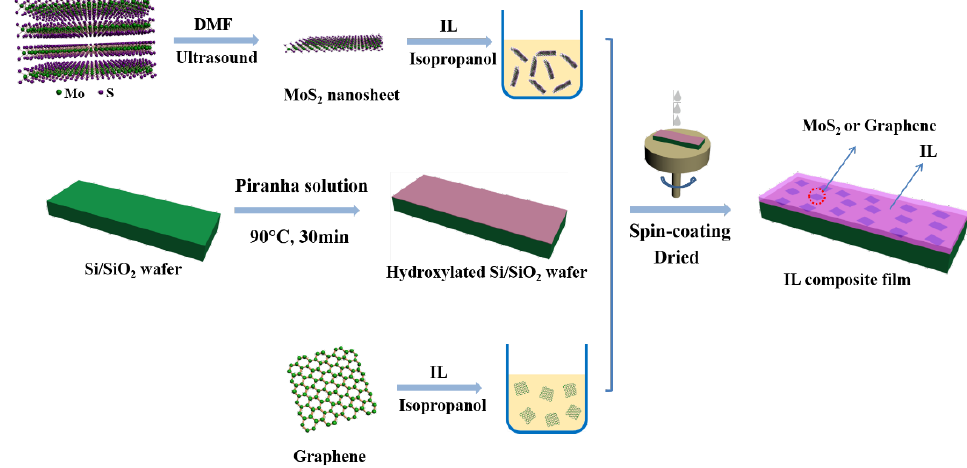
Figure 1. Preparation of the IL/MoS 2 or IL/graphene composite films via a spin-coating